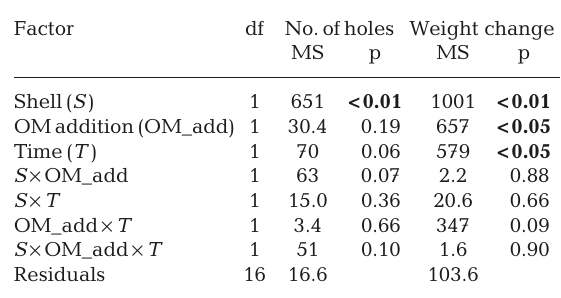
Table 2. ANOVA of sediment−water fluxes of ammonium, nitrate and nitrite in non-bioturbated (no polychaetes pres-